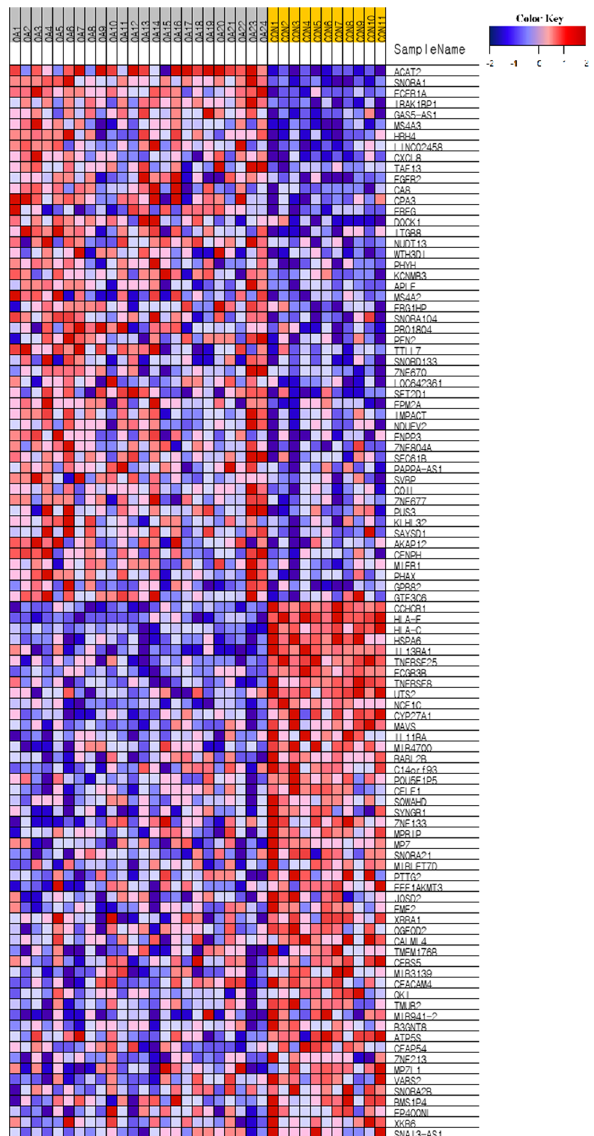
Figure. 2. Heatmap demonstrating the expression patterns of DEGs between RNAOA and CON. The color key at the top indicates relative gene expression. Red and blue colors represent higher and lower gene expression levels, respectively. The figure was obtained from GSEA, version 4.0.3 (http:// www. gsea- msigdb.